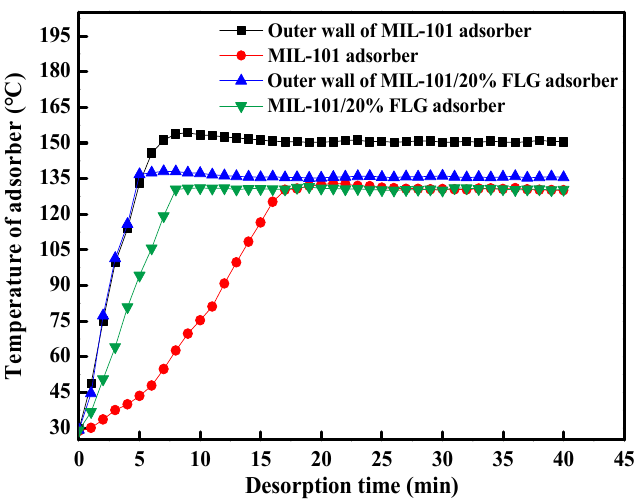
Figure 5. Variation of temperatures between outer wall and inner MIL-101/20%FLG and MIL-101 adsorbers during the heating desorption process. adsorbers during the heating desorption